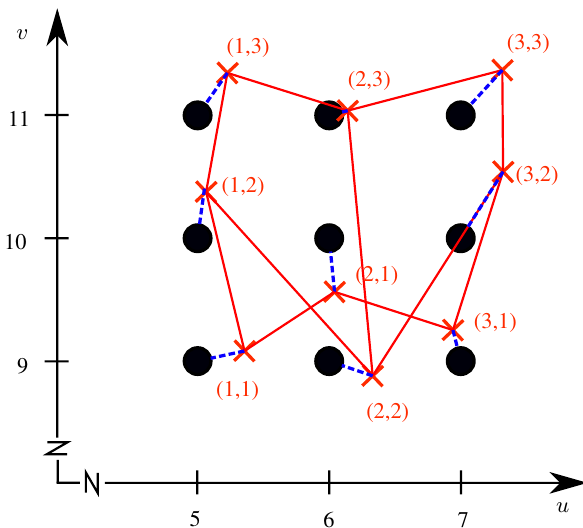
Figure 4: Example of an intermediate matching result. Black dots mark lattice nodes which were derived from the rectified optical oblique image. They can be described by their ( u, v ) indices. Red crosses symbolize PS projected into the optical image. Their indices ( a, b ) which are the result of the grouping procedure in the SAR domain are given in red. The matching result of this iteration is shown as blue dashed lines. A contradiction is present in the lower middle part.